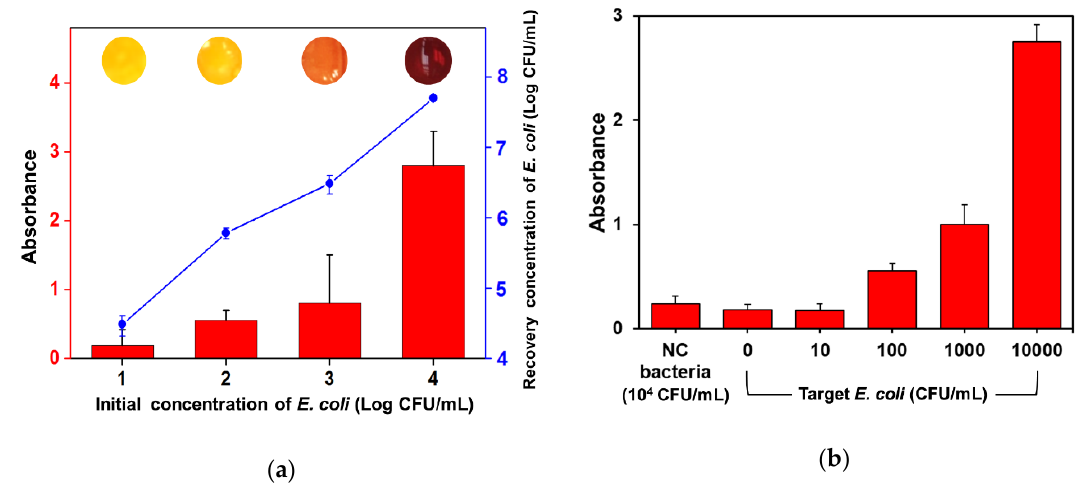
Figure 6. Enzyme reaction based colorimetric detection of E. coli O157:H7 from milk samples: ( a )